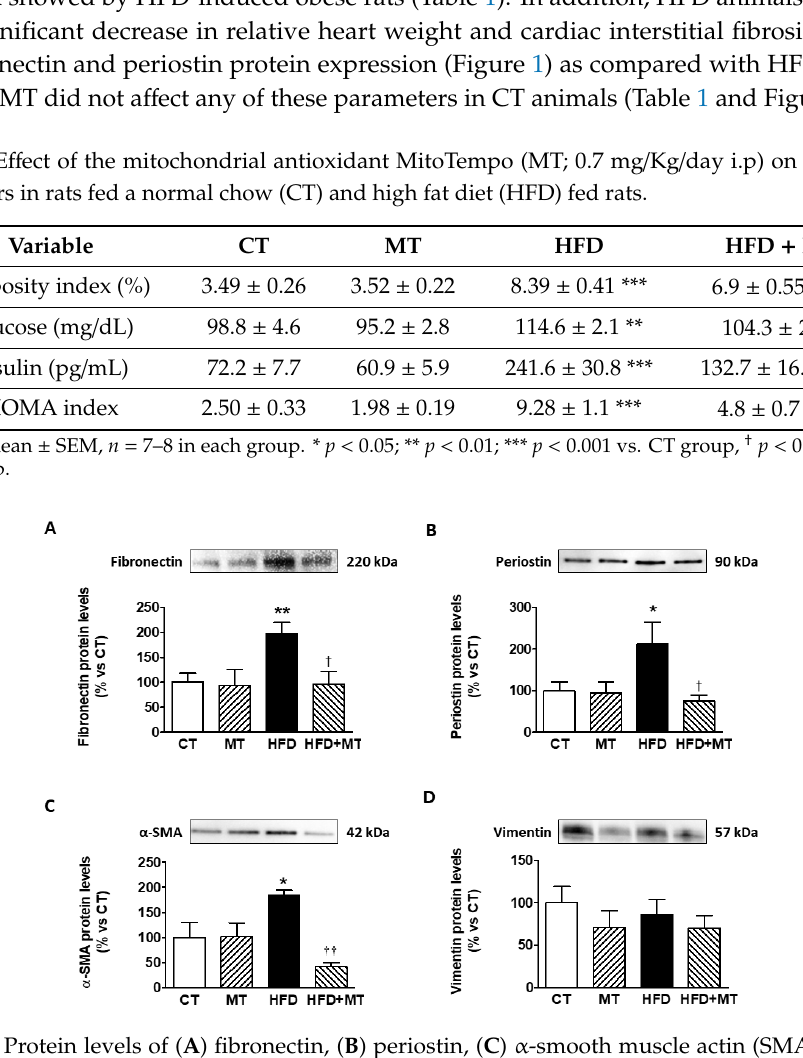
Figure 1. Protein levels of ( A ) fibronectin, ( B ) periostin, ( C ) α -smooth muscle actin (SMA) and ( D ) vimentin in heart from control rats fed a normal chow (CT) and rats fed a high fat diet (HFD) treated with vehicle or with the mitochondrial antioxidant MitoTempo (MT; 0.7 mg / Kg / day i.p). Bars graphs represent the mean ± SEM of 6–8 animals. Protein densitometry was expressed in arbitrary units (AU) once normalized to stain-free gel for protein.* p < 0.05; ** p < 0.01 vs. CT group. † p < 0.05, †† p < 0.01 vs. HFD